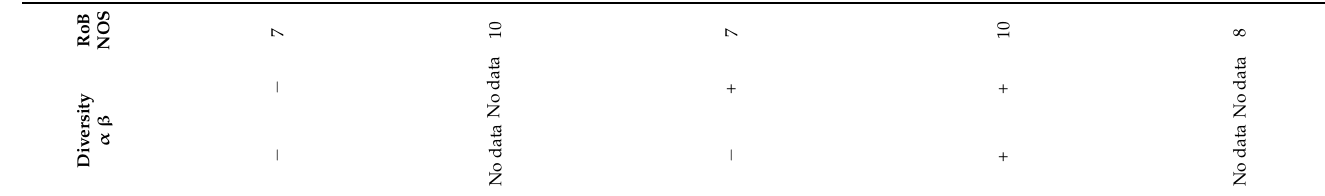
Table 1. Key characteristics of included studies. Legend: RoB—the risk of bias,